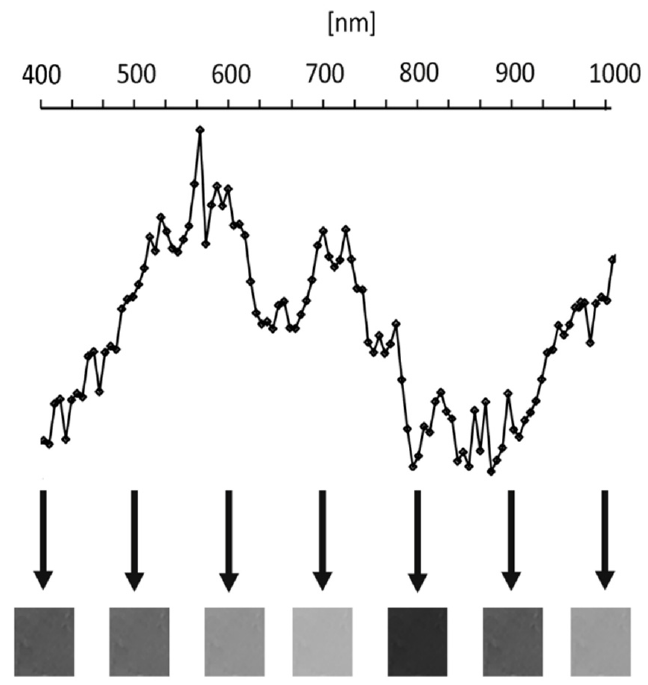
Figure 2. Schematic diagram of the hyperspectral imaging system.